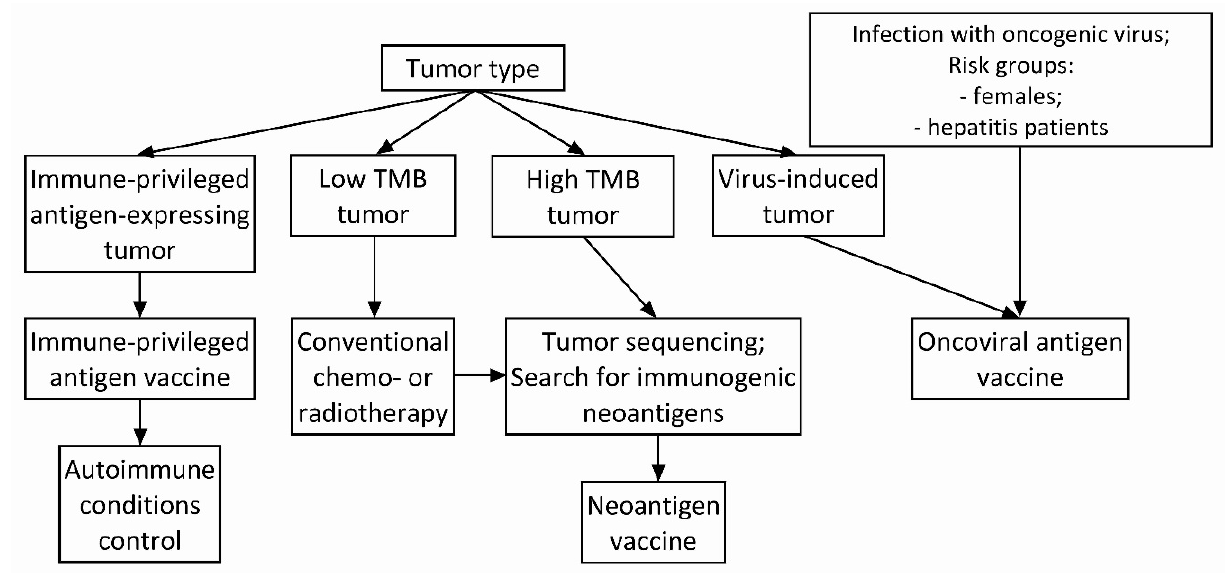
Figure 5. Tumor antigen selection strategy for cancer vaccines.